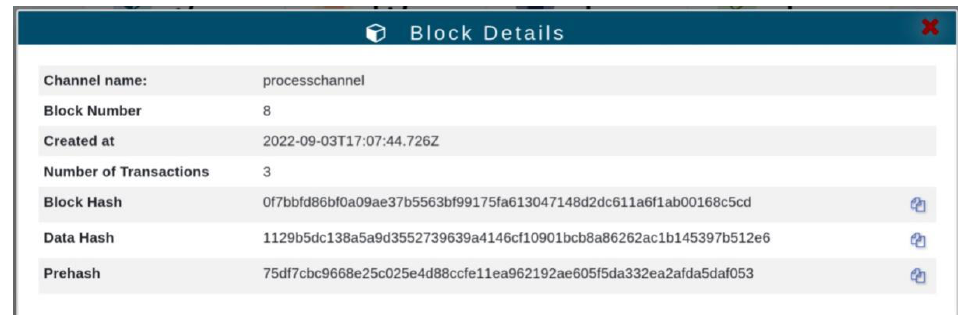
Figure 6. Transaction data generated by production units.